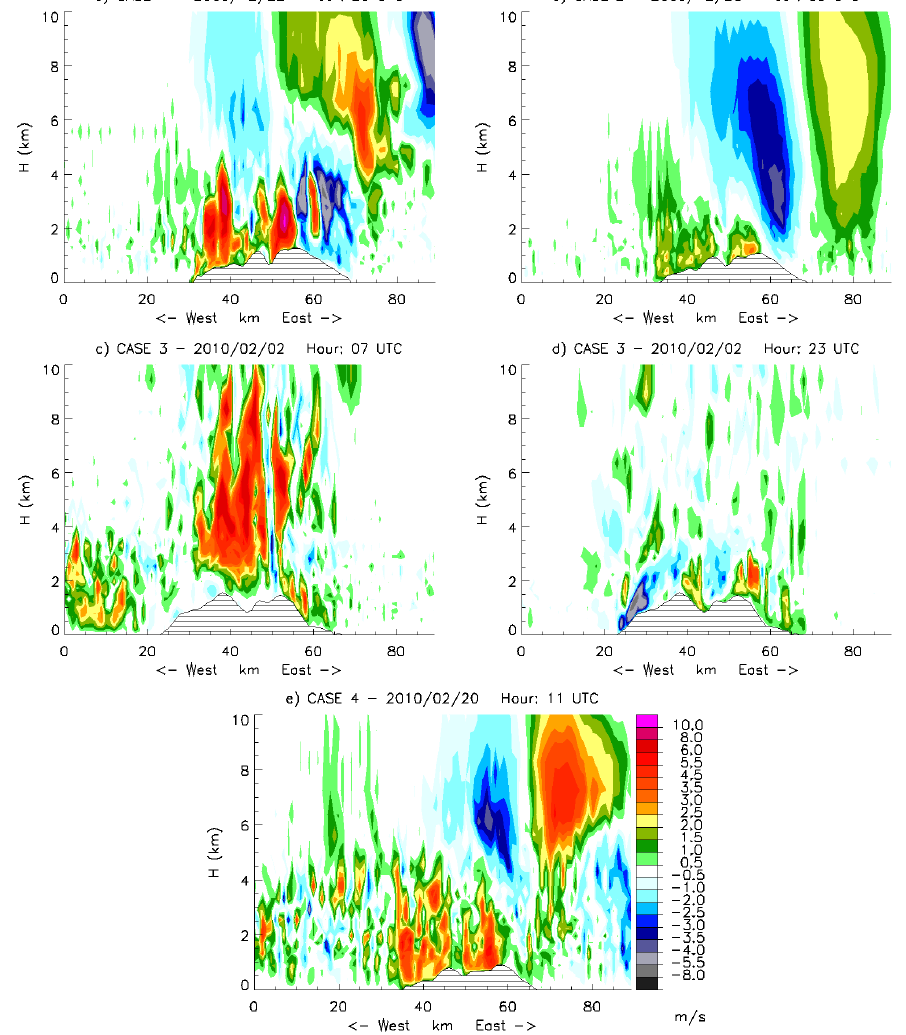
Figure 11. Vertical east-west cross-section of the vertical velocity (m/s) simulated with 2 Fig. 11. Vertical east–west cross-section of the vertical velocity (ms − 1 ) simulated with MESO-NH for (a) 22 December 2009 – 20:00UTC MESO-NH for (a) 22/DEC/2009 – 20 UTC and cross-section in y=27.7; (b) 28/DEC/2009 – 3 and cross-section in y = 27.7; (b) 28 December 2009 – 05:00UTC and cross-section in y = 26; (c) 2 February 2010 – 07:00UTC and cross- section in y = 34; (d) 2 February 2010 – 23:00UTC and cross-section in y = 34; and (e) 20 February 2010 – 11:00UTC and cross-section 05 UTC and cross-section in y=26; (c) 02/FEB/2010 – 07 UTC and cross-section in y=34; (d) 4 in y = 02/FEB/2010 – 23 UTC and cross-section in y=34; and (e) 20/FEB/2010 – 11 UTC and cross-5 section in y=25. 6